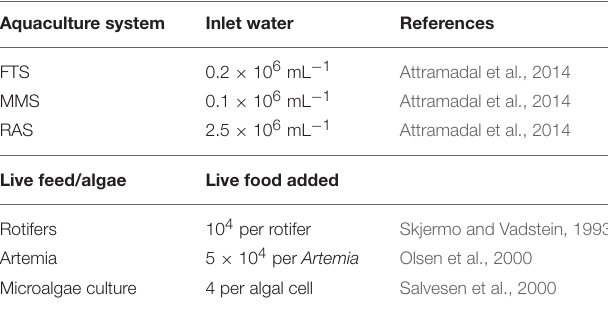
density of 100 larvae L − 1 and a survival of 30% at 30 dph. TABLE 1 | Bacterial densities of main sources during larval rearing in three different types of rearing systems.